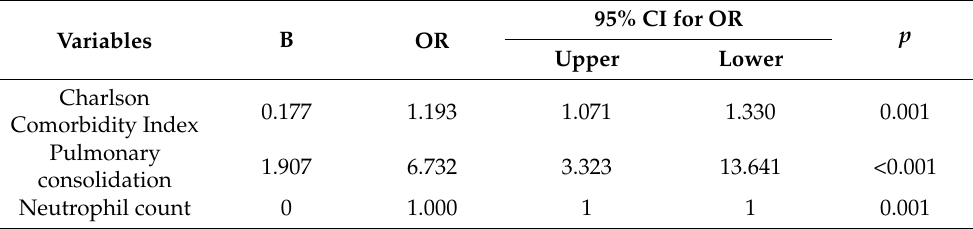
Table 3. Factors associated with antibiotic prescription (logistic